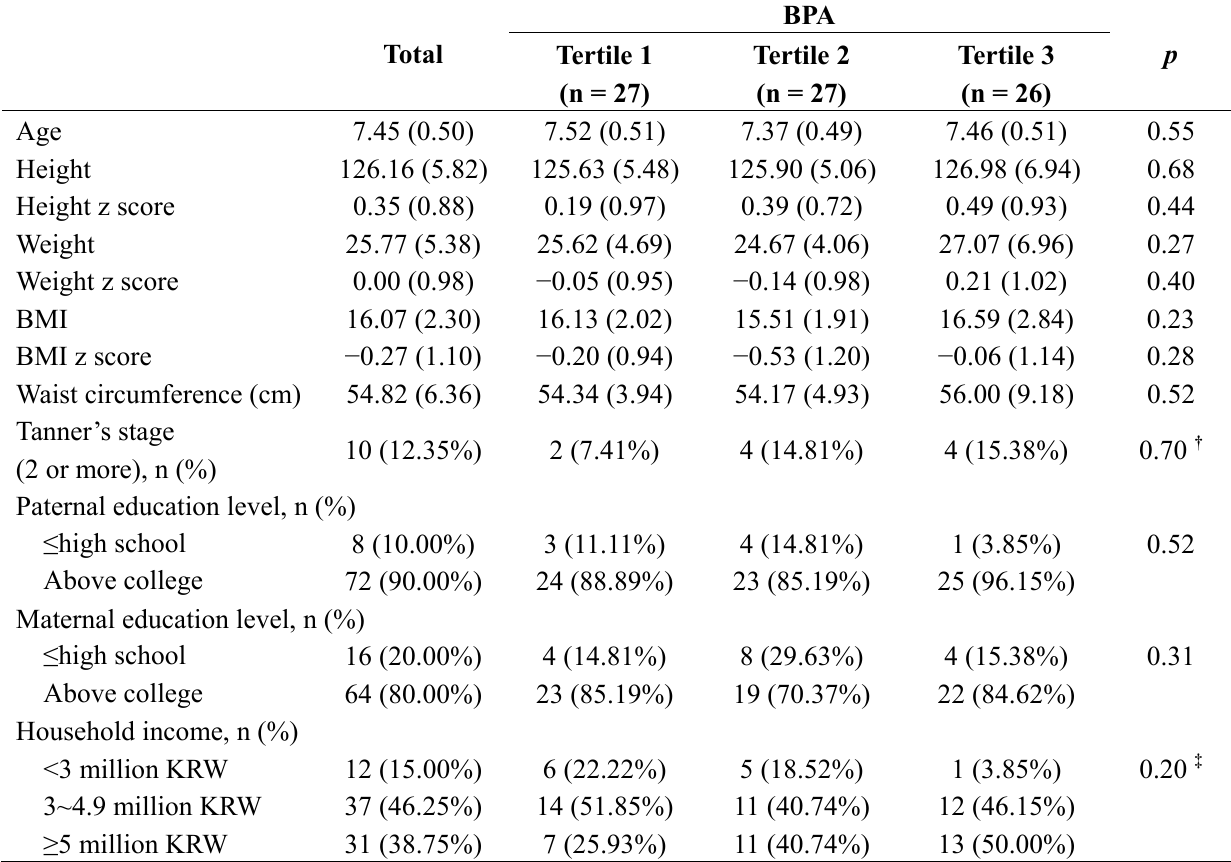
Table 2. Baseline characteristics of study subjects based on urinary bisphenol A concentration (n =